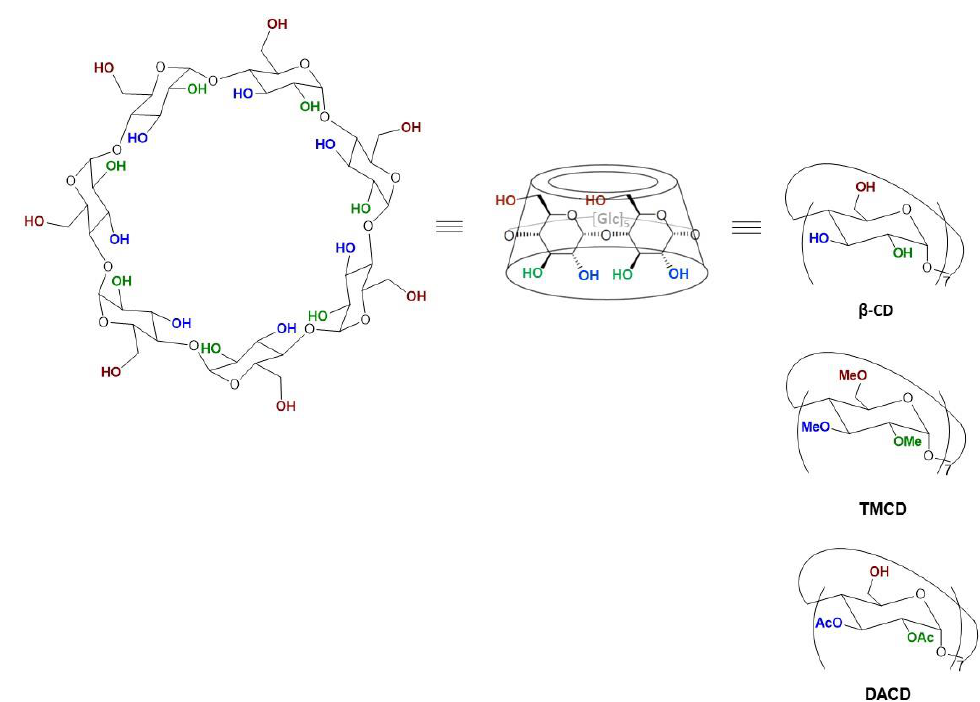
Figure 1. β -Cyclodextrins and functionalized cyclodextrins Figure 1. β-Cyclodextrins and functionalized cyclodextrins (CDs).